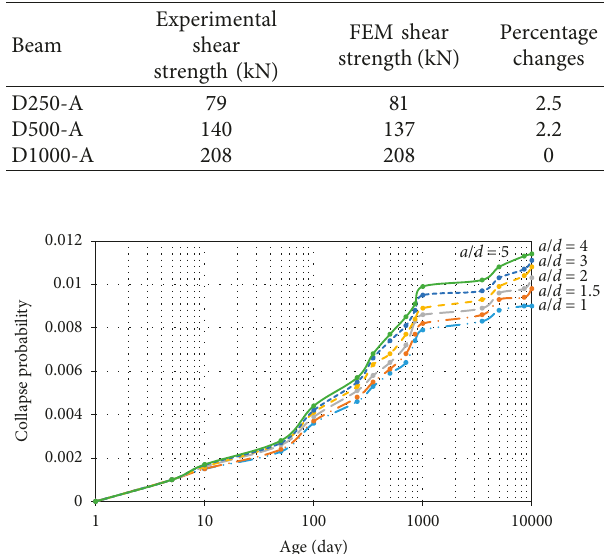
Figure 8: Collapse probability of failure in RC beams related to the strength limit state at the load level of P strength, L (cid:29)